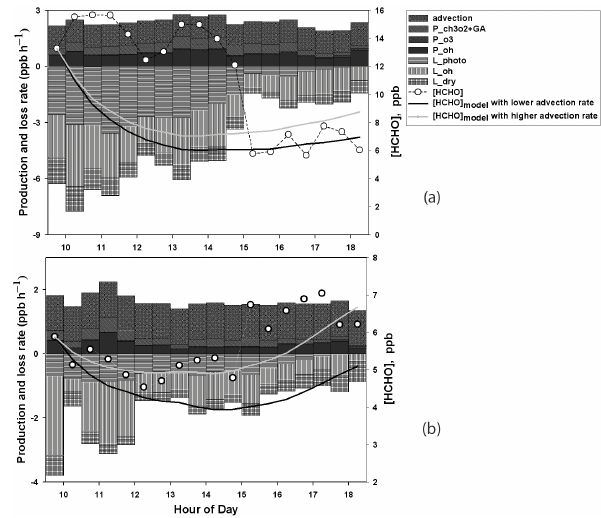
Fig. 11. Mean diurnal HCHO production rate (ppbh − 1 ) from CH 3 O 2 radical, which is produced from PA (white), CH 4 (light gray), and glycolaldehyde (dark gray) during (a) the High and (b) Low HCHO period.